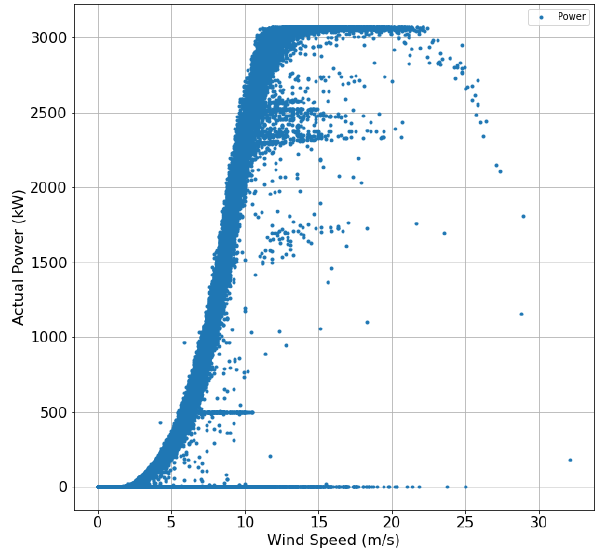
Figure 4. Relation ship between power and wind speed.